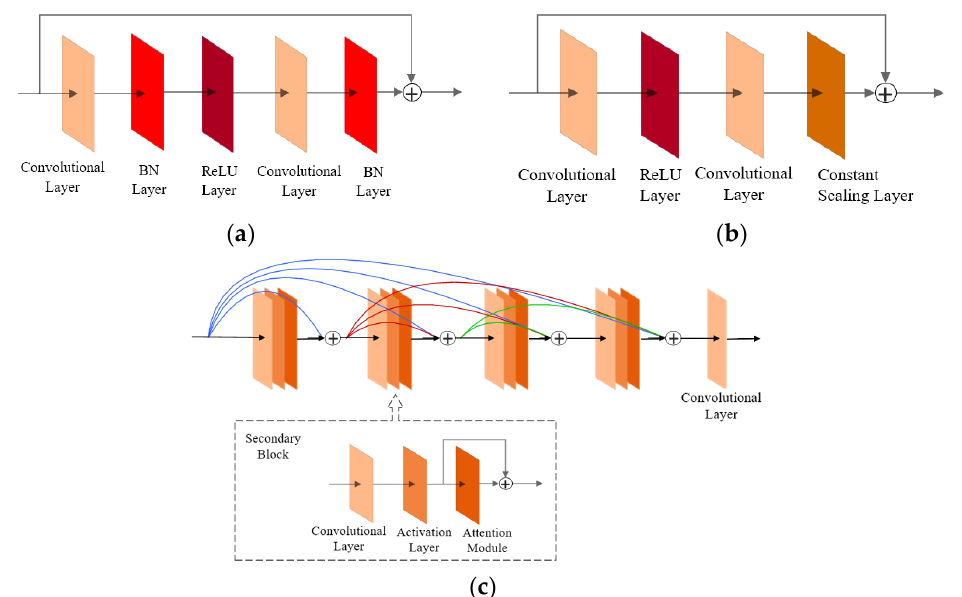
Figure 10. Comparison of residual block structures ( a ) residual blocks used by SRResNet and SRGAN; ( b ) residual blocks proposed by EDSR; ( c ) residual blocks used in this study.